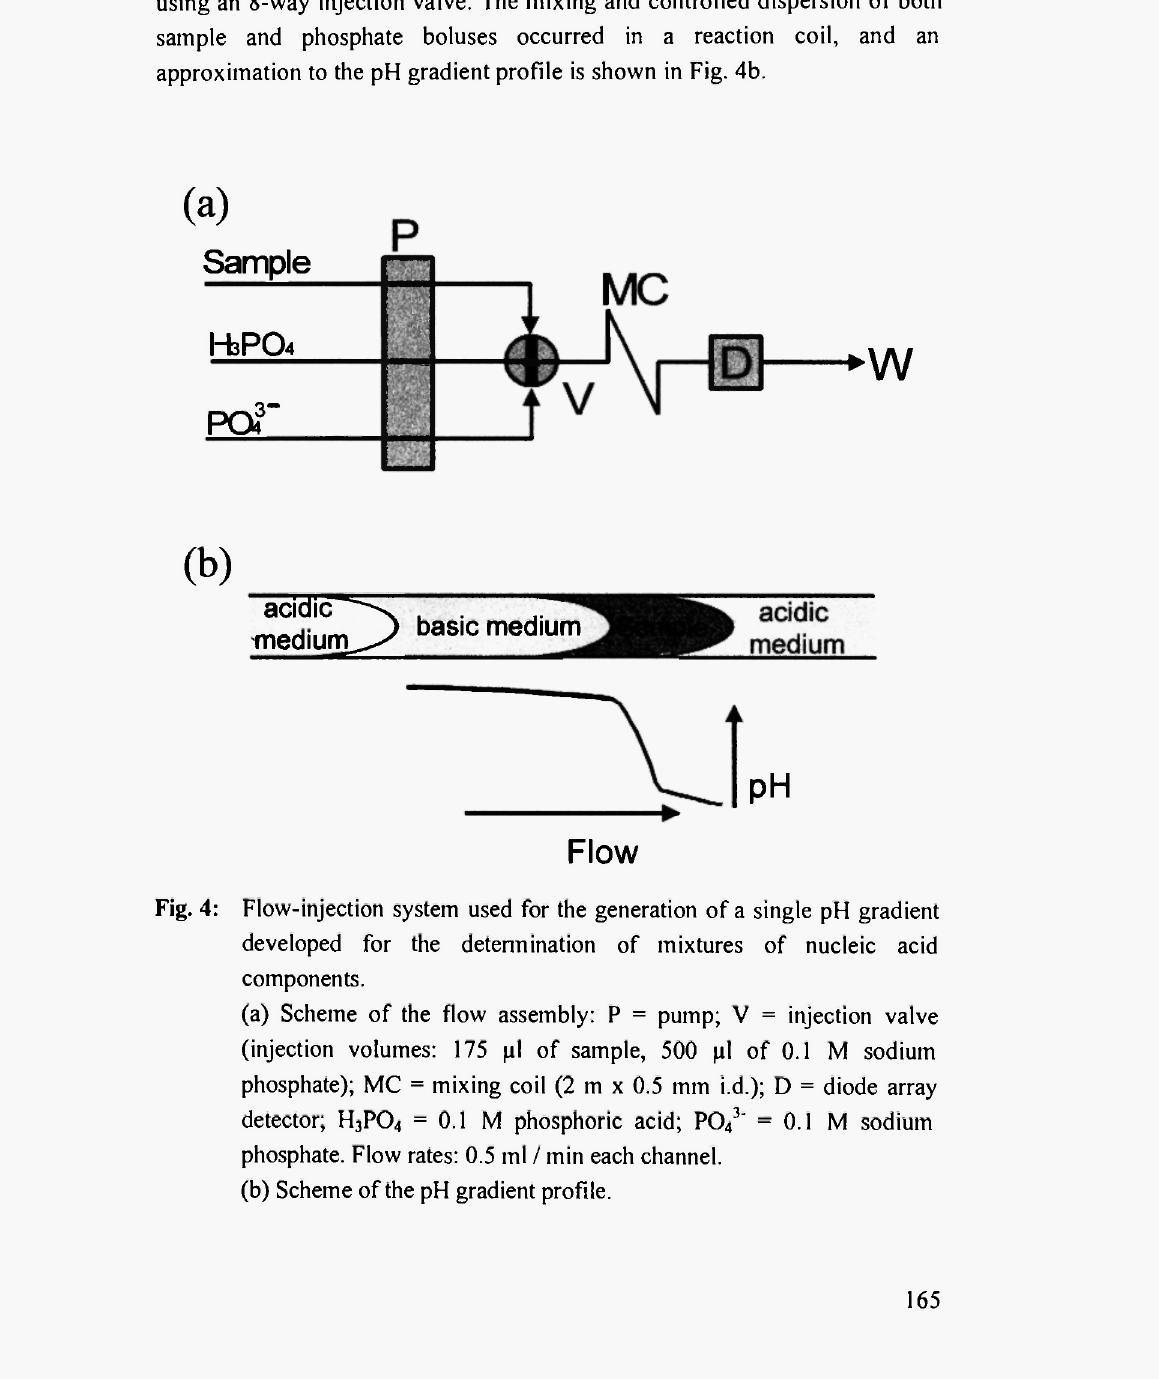
Fig. 4: Flow-injection system used for the generation of a single pH gradient developed for the detenuination of mixtures of nucleic acid